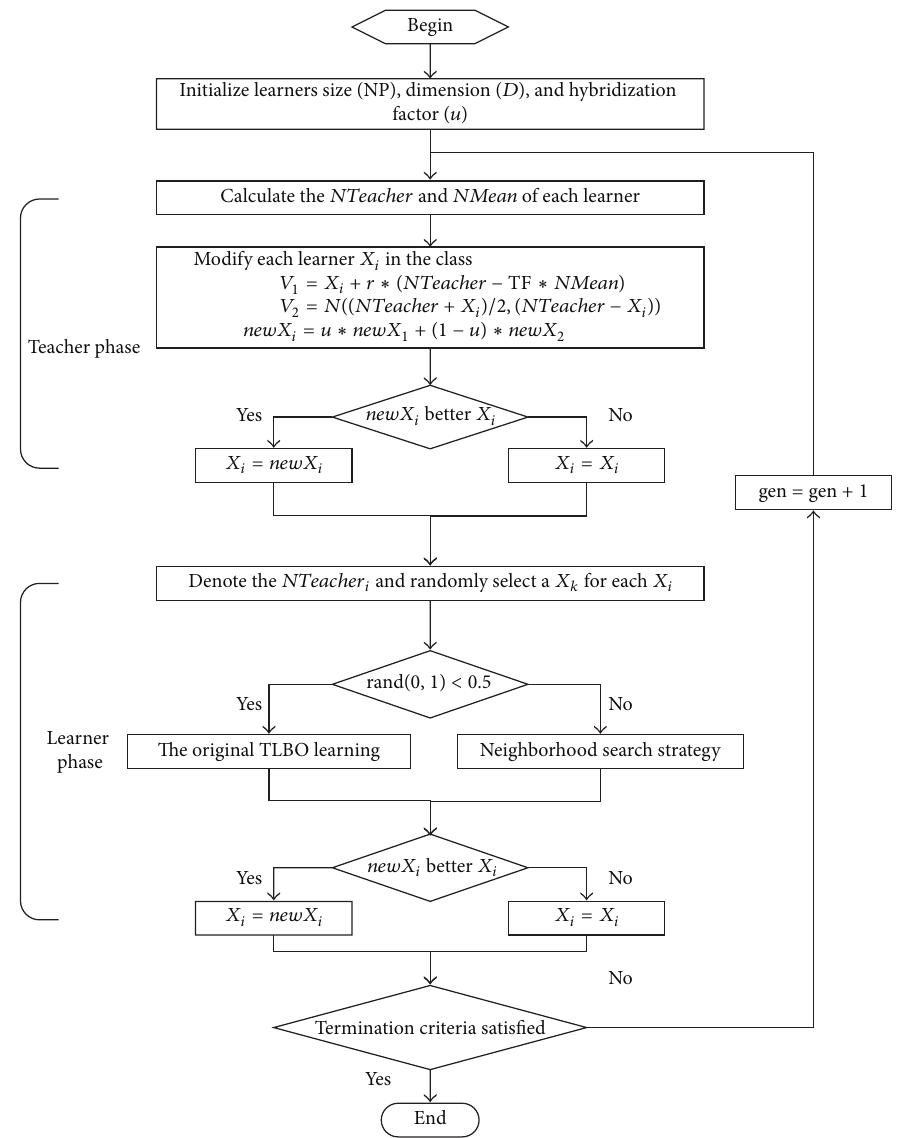
Figure 1: Flow chart showing the working of BBTLBO